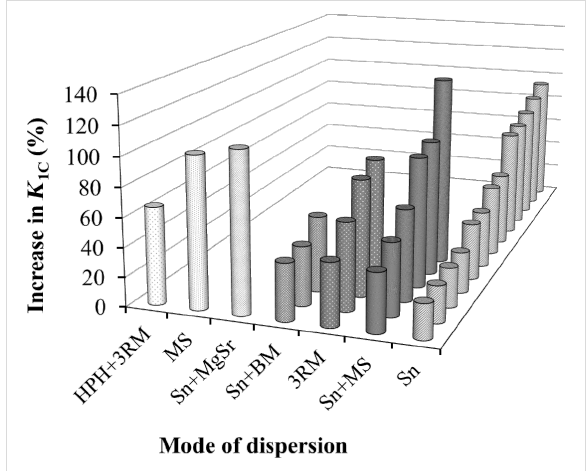
Figure 9: The maximum improvement in K 1C as a function of disper- sion mode [17,60-62,79-104].